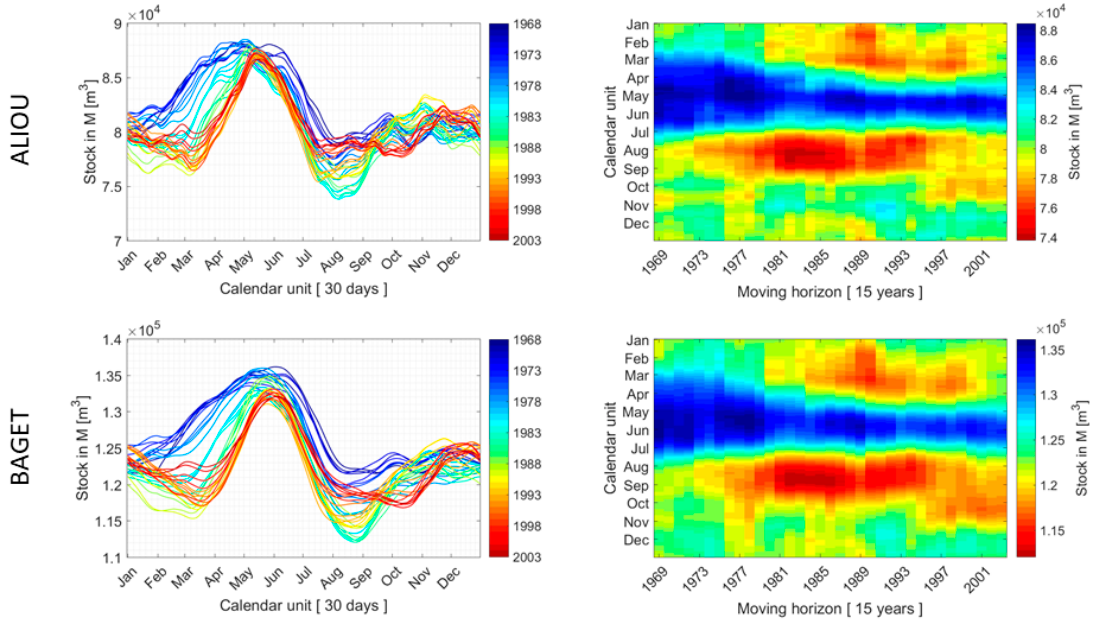
Figure 5. MASH of the estimated water volume in the reservoir M (w = 30 days, Y = 15 years).